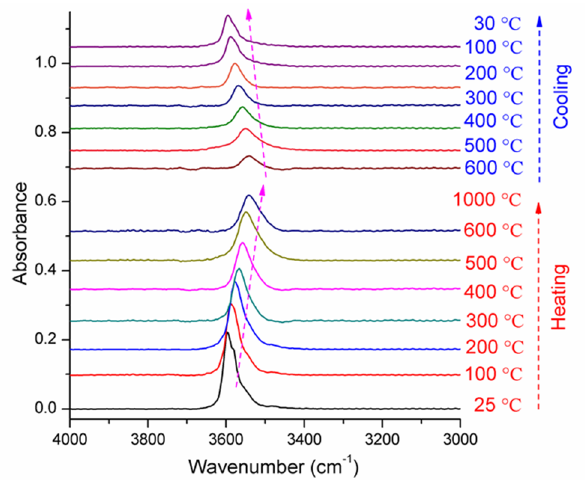
Figure 9. IR spectra change in shape and position of the OH absorptions with temperature (infrared light perpendicular to (010), electric vector E of the light wave is parallel to [001]).